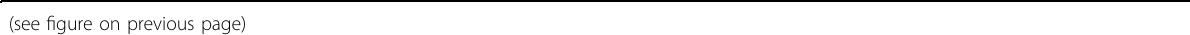
(see fi gure on previous page) Fig. 5 NAC treatment inhibited cell senescence and TIME signaling in Bmi-1 − / − more than in Bmi-1 − / − p16 − / − pulmonary fi broblasts. Pulmonary fi broblasts from 7-week-old WT, Bmi-1 − / − , Bmi-1 − / − p16 − / − , and NAC-treated Bmi-1 − / − ( Bmi-1 − / − + NAC) mice. a Representative micrographs of cells stained cytochemically for SA- β -gal. b Percentage of SA- β -gal-positive areas relative to the total areas. c Third-passage fi broblast proliferation was determined by CCK-8 assays and spectrophotometry at 450 nm. Cell number was determined at the indicated hours relative to the cell number at hour 0. d TGF- β 1 and IL-11 concentrations were detected in conditioned medium (CM) by ELISA and assessed by densitometric analysis relative to that of WT CM. e , f Western blots for mature TGF- β 1, IL-11, p19, p53, p21, α -SMA, p16, pERK1/2 (Thr202/Tyr204), and ERK1/2. β -actin was used as the loading control. g Protein expression relative to β -actin was assessed by densitometric analysis. h Representative micrographs showing immuno fl uorescence for IL-11 and p53, with DAPI staining the nuclei. i Percentage of IL-11-positive areas (in p53-positive cells) or p53- positive areas relative to the total area assessed. Six biological replicates were used per experiment. Values are the means ± SEM of six determinations. * P < 0.05, ** P < 0.01, *** P < 0.001 compared with the WT group; # P < 0.05, ## P < 0.01, ### P < 0.001 compared with the Bmi-1 − / − group; & P < 0.05, && P < 0.01 compared with the Bmi-1 − / − p16 − / − group. j Western blots of pulmonary fi broblasts from the NAC (1 m M , 48 h)-treated Bmi-1 − / − ( Bmi-1 − / − + NAC) group and the NAC (1 m M , 48 h) & MG132 (5 μ M , 48 h)-treated Bmi-1 − / − ( Bmi-1 − / − + NAC + MG132) group. k Protein expression relative to β -actin was assessed by densitometric analysis. Six biological replicates were used per experiment. Values are the means ± SEM of six determinations. ** P < 0.01, *** P < 0.001 compared with the NAC-treated Bmi-1 − / −